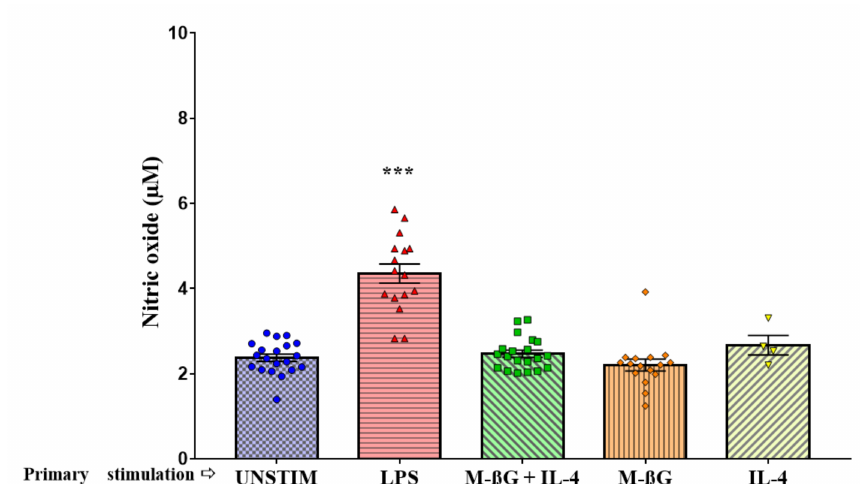
Figure A2. Bone marrow-derived adherent cells primary stimulation with LPS resulted in enhanced NO production. Fresh isolated chicken bone marrow-derived adherent cells were primary stimulated with culture medium (UNSTIM), LPS (10 µ g / mL), M- β G (10 µ g / mL), M- β G + IL-4 (10 µ g / mL + 100 ng / mL) or IL-4 (100 ng / mL). LPS induced NO production ( N = 12–20 chickens; N for IL-4 = 4 chickens). Each bar represents mean ± SEM. *** p <